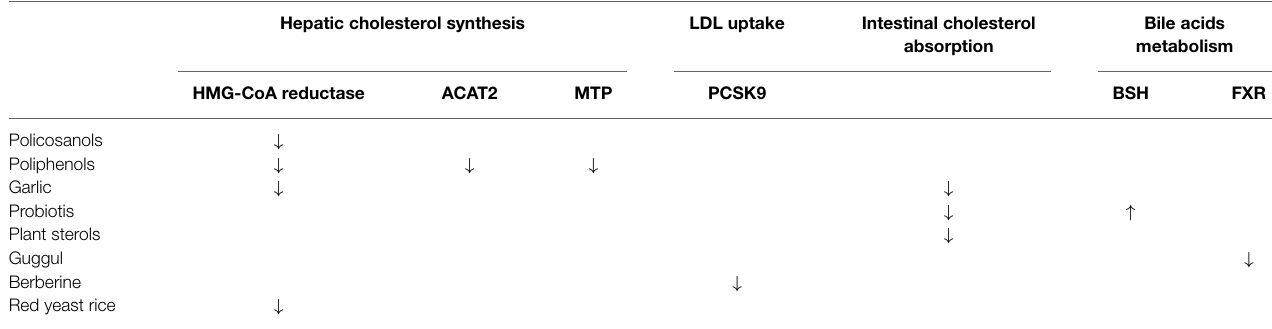
TABLE 1 | Mechanisms of action of different hypothetical nutraceuticals with recommended lipid-lowering effect .